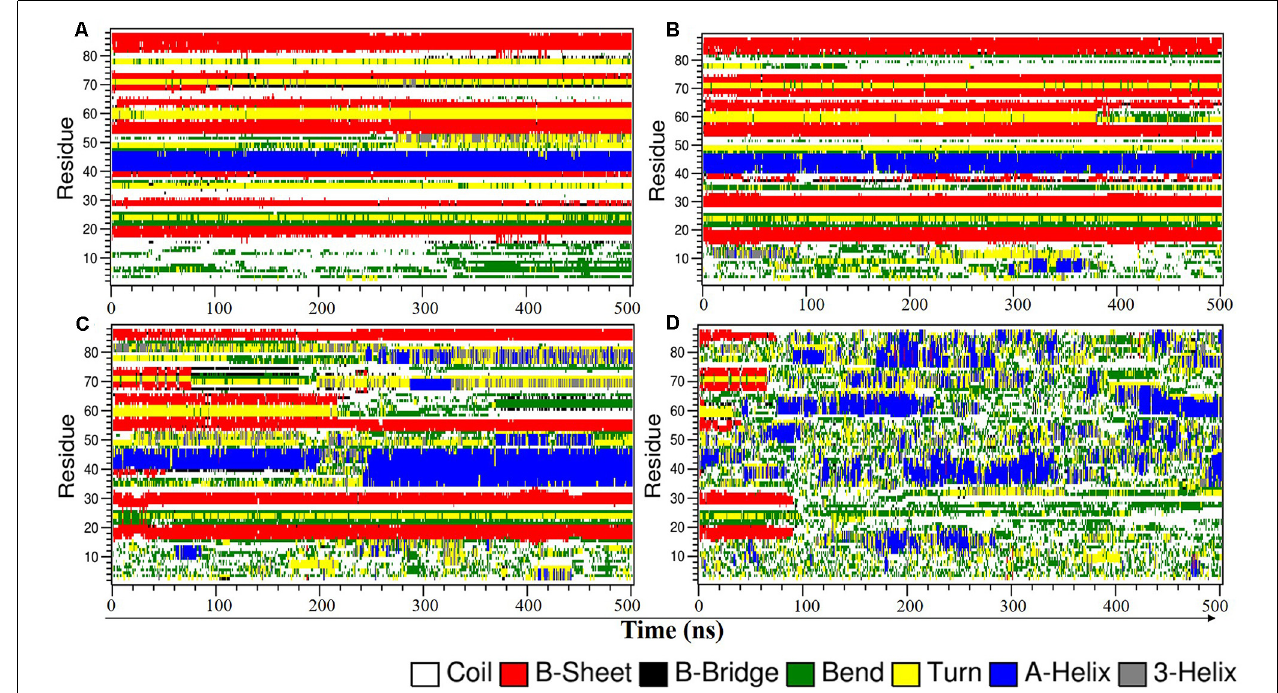
FIGURE 2 | Time evolution plot of NTD secondary structure using DSSP in 8 M DMSO at (A) 300 K, (B) 350 K, (C) 400 K, and (D) 450 K. DMSO,